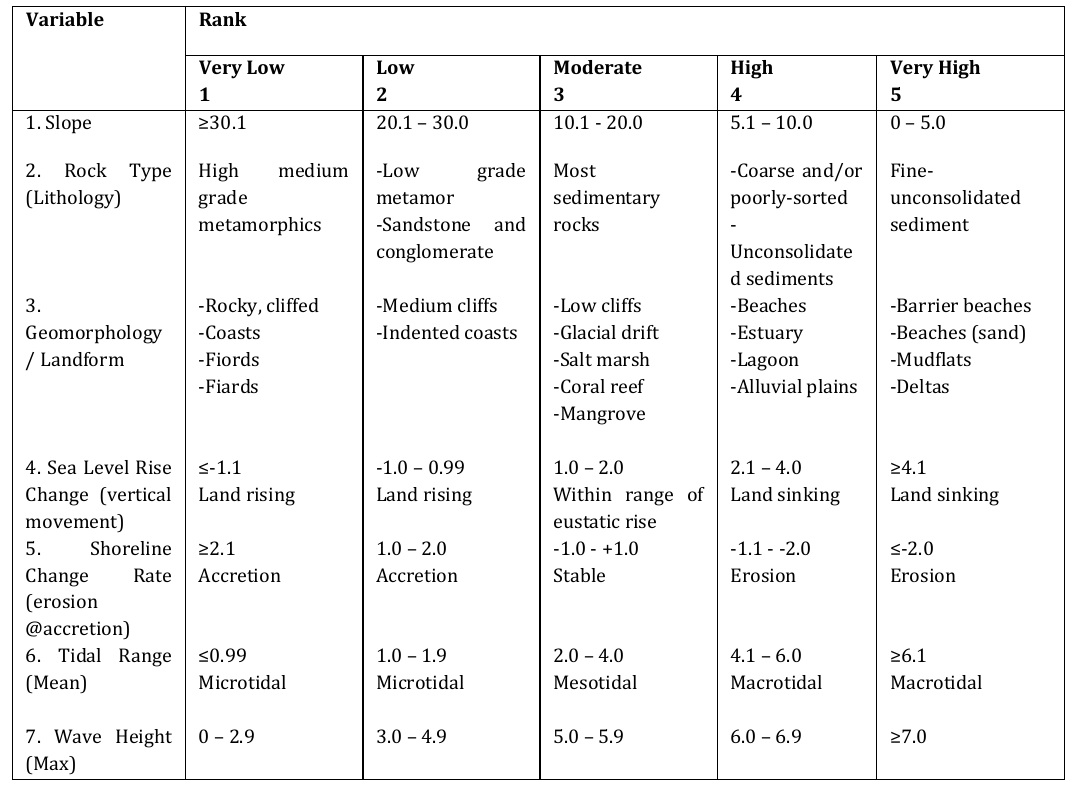
Table 8: Ranking of coastal risk classes for physical variables [17].